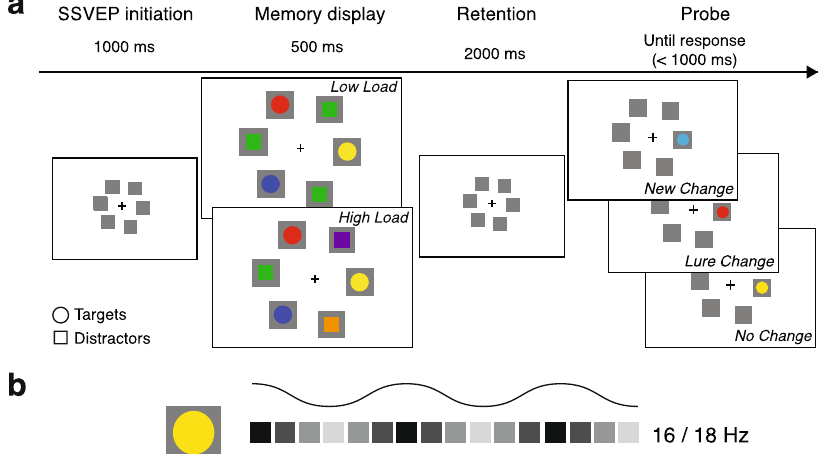
Figure 1. Experimental design. ( a ) Graphical display of the change-detection task with distractors. In this example targets were circles, and distractors were squares. In each trial, participants were shown a memory display with homogenously (low distractor load; top panel) or heterogeneously colored distractors (high distractor load; bottom panel). Distractor load was manipulated block-wise. After a retention interval, a probe stimulus was presented at one of the target locations. The probe could either have a new color (new change trials; top panel), a color of one of the target stimuli at a non-probed location (lure trials; middle panel), or a color identical to the target stimulus at that location (no change; bottom panel). ( b ) Stimulus contrast of the placeholders at stimulus locations was manipulated in a sinusoidal fashion from black to white to elicit SSVEPs at 16 and 18 Hz. Target and distractor locations flickered at different